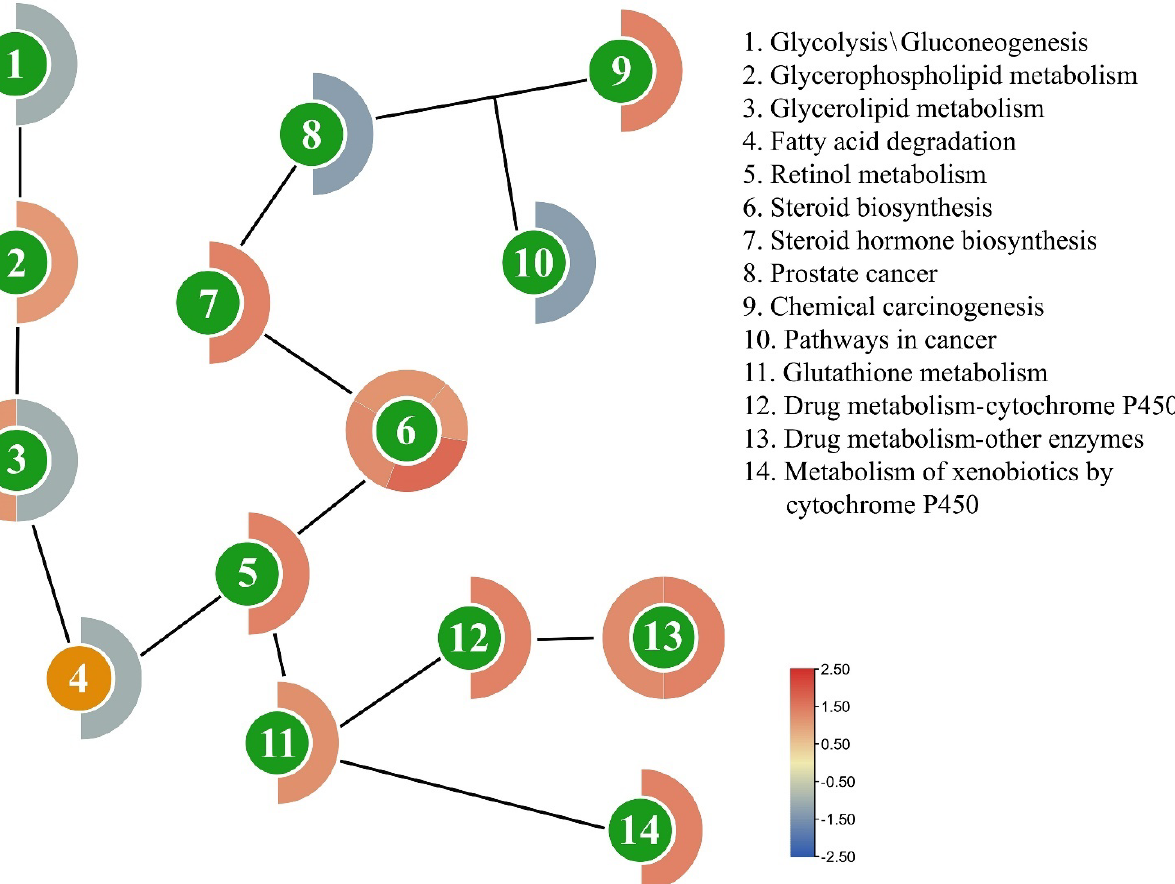
Table 2. A list of insecticide detoxification genes regulated in the transcriptional data of Solenopsis invicta .